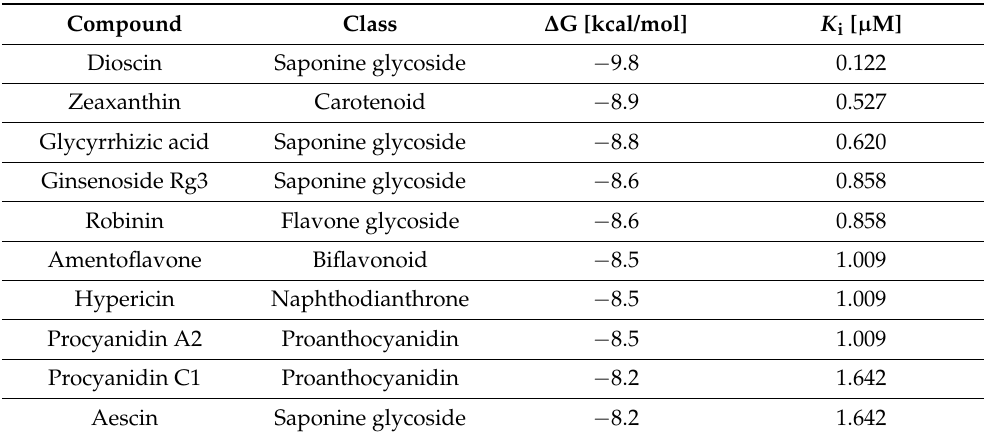
Table 1. Virtual screening hits, their binding free energies, and theoretical inhibition constants (at T = 310.15 K).